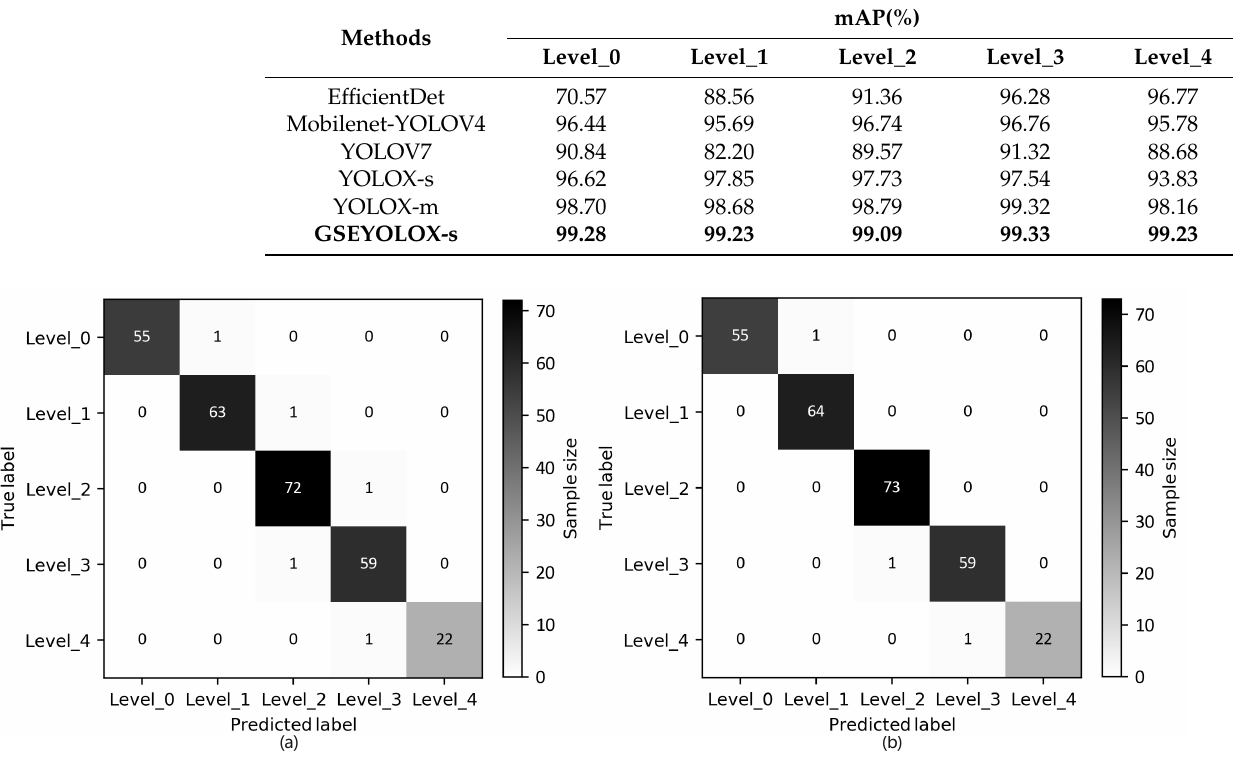
Figure 5. Confusion matrixes of YOLOX-s ( a ) and GSEYOLOX-s ( b ) on test